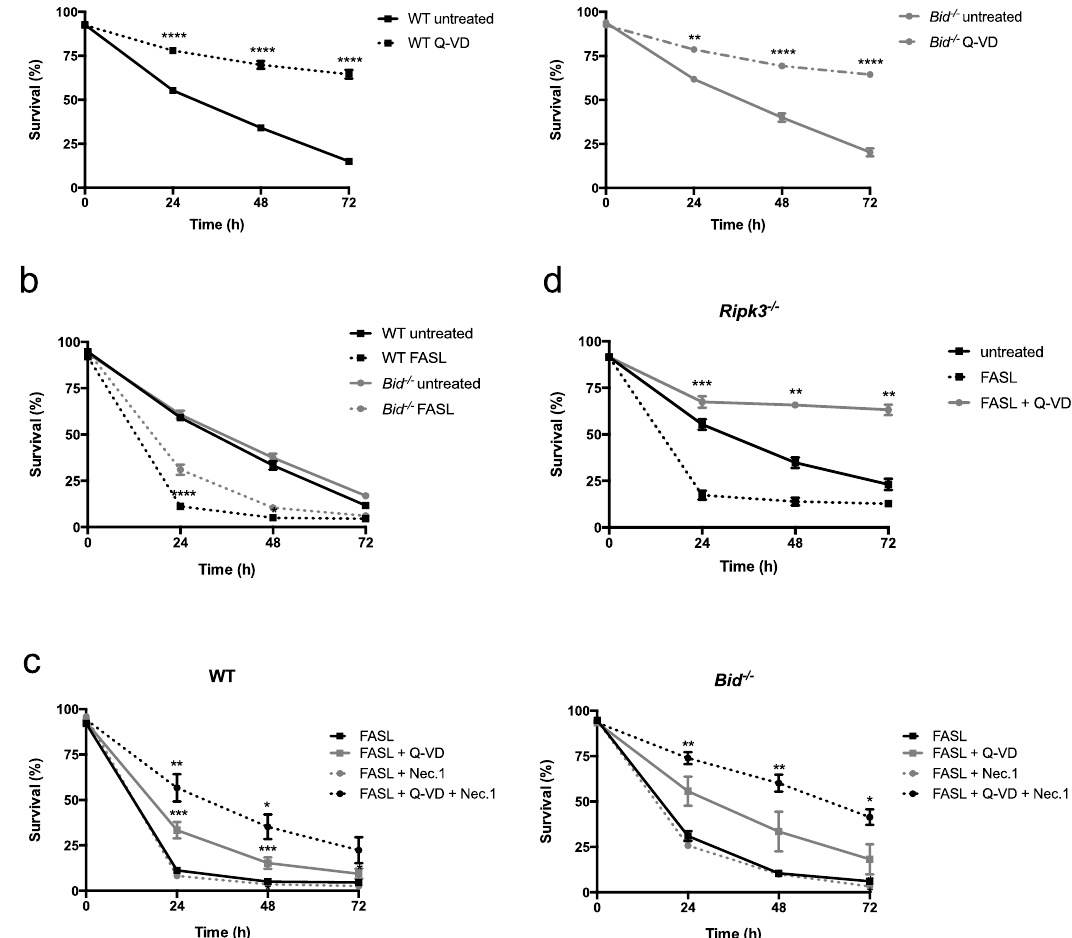
Figure 1. Mouse neutrophils undergo cell death in response to FASL, which is delayed by loss of BID. ( a ) Assessment of viability of WT and Bid − / − neutrophils left untreated (spontaneous apoptosis) or treated with the pan-caspase inhibitor Q-VD-OPh (20 µ M) for indicated time points. n ≥ 6, mean ± SEM. ( b ) Assessment of viability of WT and Bid − / − neutrophils upon treatment with FASL (100 ng/mL) for indicated time points. n ≥ 3, mean ± SEM. ( c ) WT and Bid − / − neutrophils were pre-treated with Q-VD-OPh (20 µ M) and/or Nec.1 (20 µ M) for 30 min followed by treatment with FASL (100 ng/mL) for indicated time points. Viability was assessed by flow cytometry. n ≥ 4, mean ± SEM. ( d ) Ripk3 − / − neutrophils were pre-treated with Q-VD-OPh (20 µ M) for 30 min and subsequently stimulated with FASL (100 ng/mL) for indicated time points. Viability was assessed by flow cytometry using GFP-AnnexinV/PI exclusion. n = 3, mean ± SEM. All experiments were performed with primary bone marrow-derived neutrophils. p < 0.05 (*), p < 0.01 (**), p < 0.005 (***) and p < 0.001 (****).